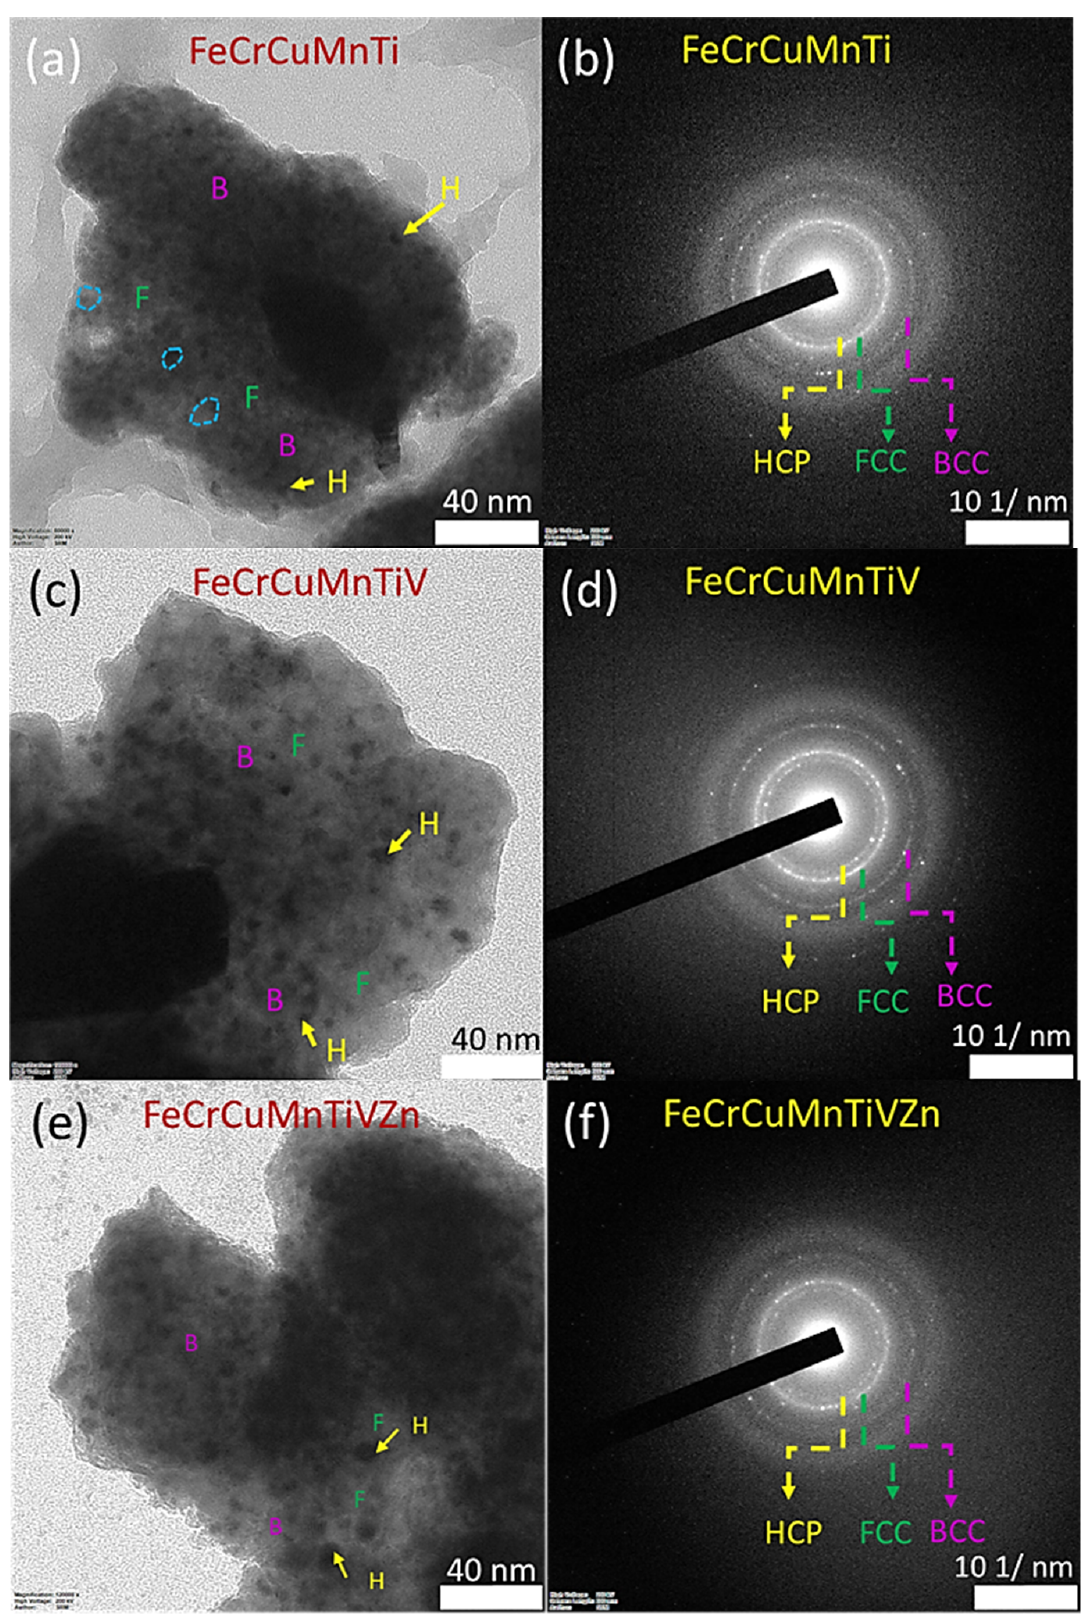
Figure 7. HRTEM microstructure of three developed HEAs: ( a , b ) FeCrCuMnTi; ( c , d ) FeCrCuMnTiV; ( e , f ) FeCrCuMnTiVZn. ( a , c , e ) Dark field images, DFI. ( b , d , f ) SAED patterns. Table 2. Chemical composition in at. wt.% of three developed HEAs taken in several regions by HRSEM-EDS. Alloy CodeEquiatomic Composition